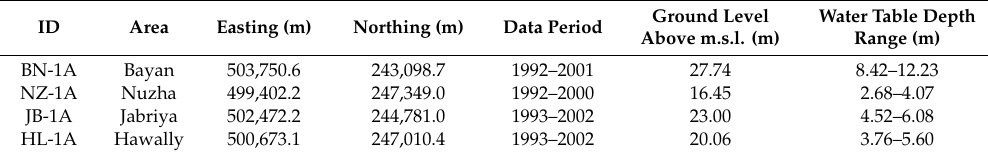
Figure 1. Study area map showing the location of the selected observation wells. Table 1. Selected observation wells in the study area. m.s.l.: mean sea level.